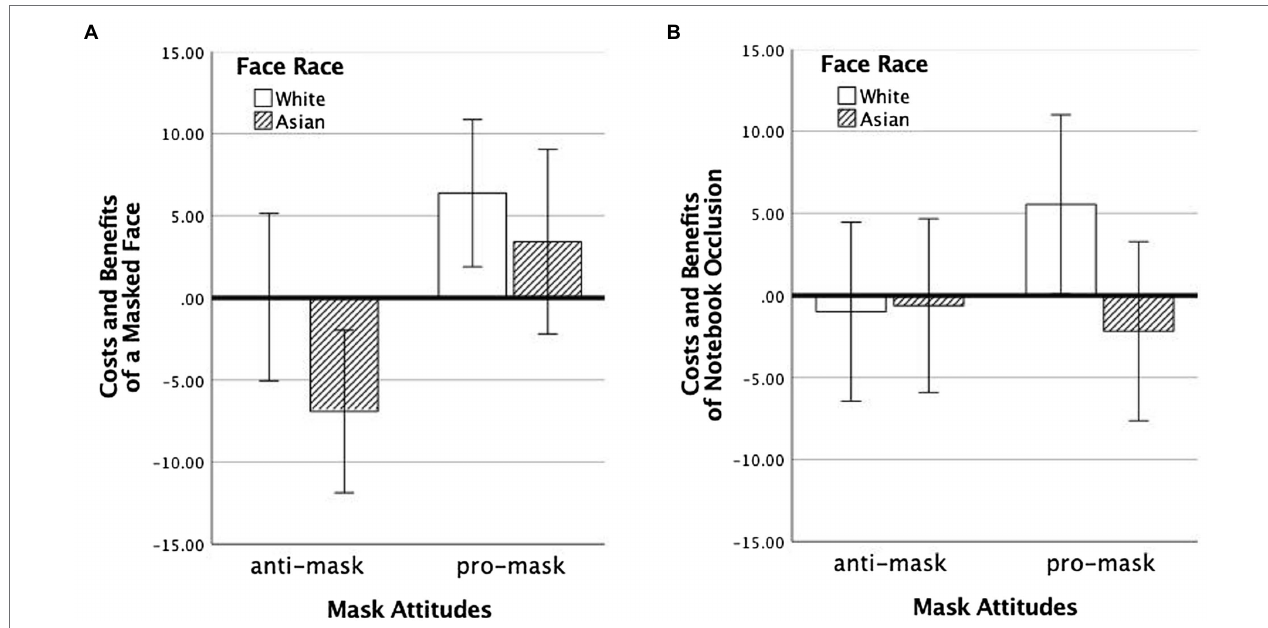
FIGURE 6 | Costs and benefits of an occluded face (computed as the difference between averaged ratings for occluded and full faces, across the three levels of baseline attractiveness) as a function of the viewer’s attitudes to masks (horizontal axis) and the race of the target face (color of the bars). Panel A shows results for faces covered with masks; Panel B shows results for faces occluded by a notebook. Error bars represent +/ − 1 standard